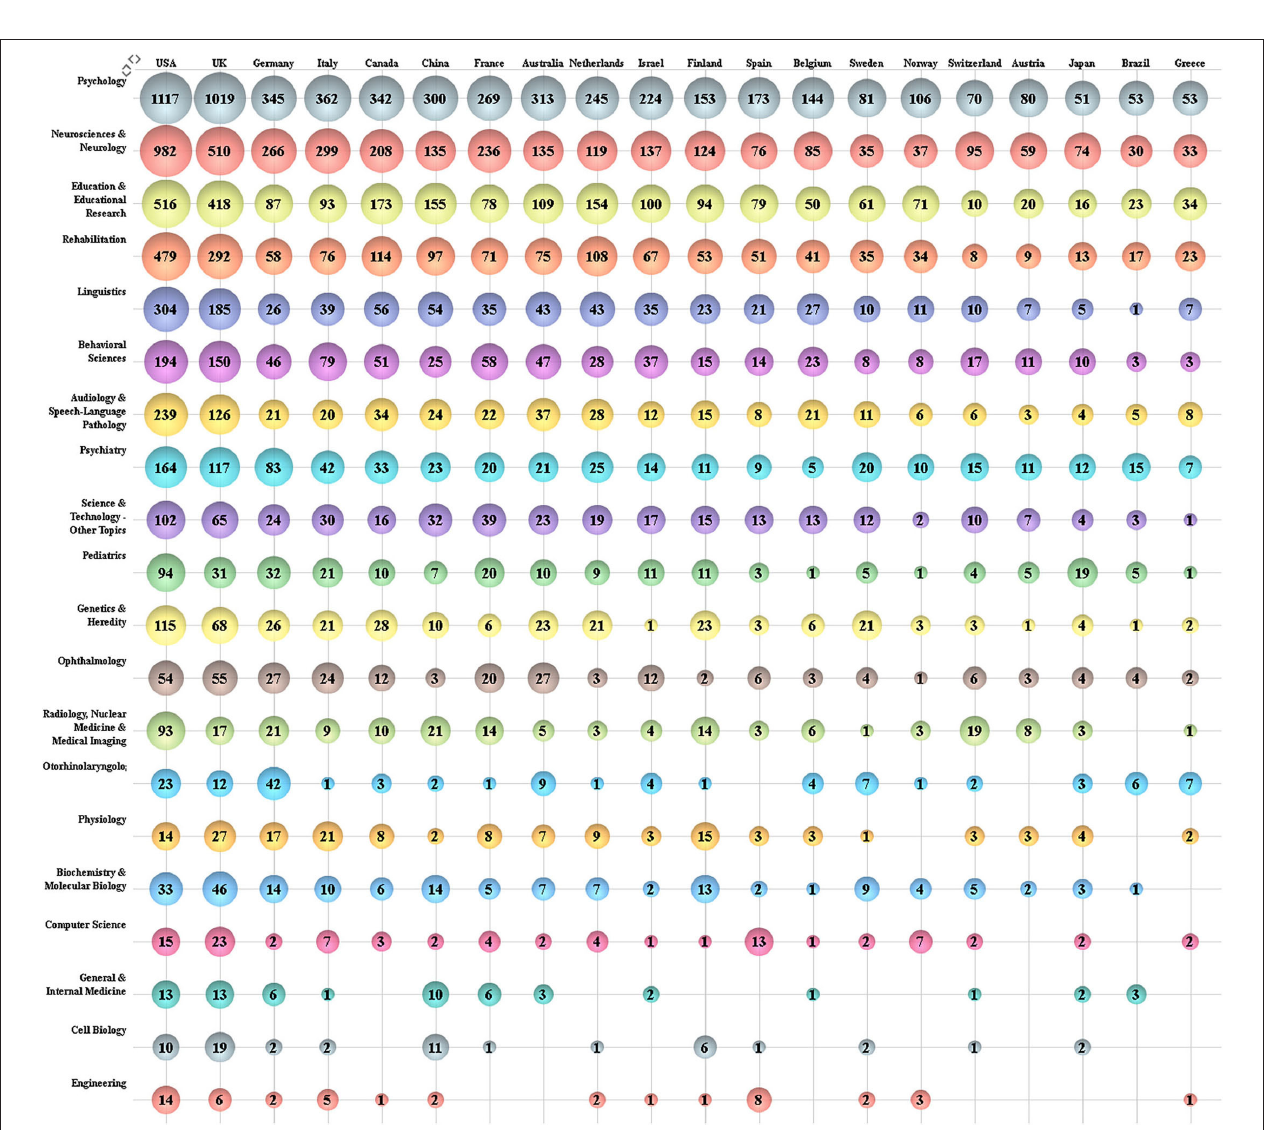
FIGURE 4 | Number of papers in the top 20 research areas by the top 20 most productive countries.